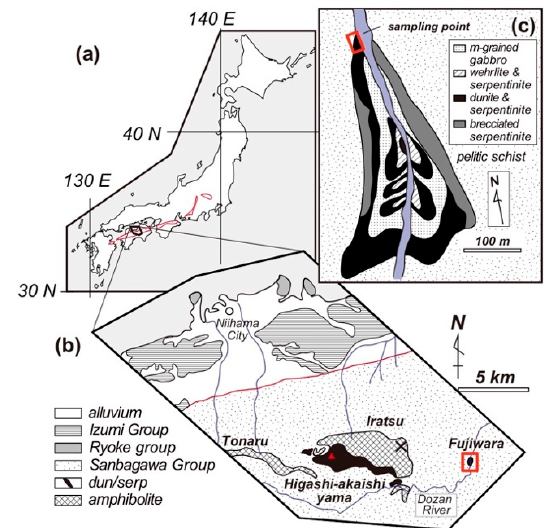
Figure 1. Location of the Fujiwara dunite in the Sanbagawa metamorphic belt, Japan. Modified from [27,28]. ( a ) The Sanbagawa metamorphic belt in Shikoku Island, southwest Japan. ( b ) Part of the Sanbagawa belt and the location of the Fujiwara body ( c ).